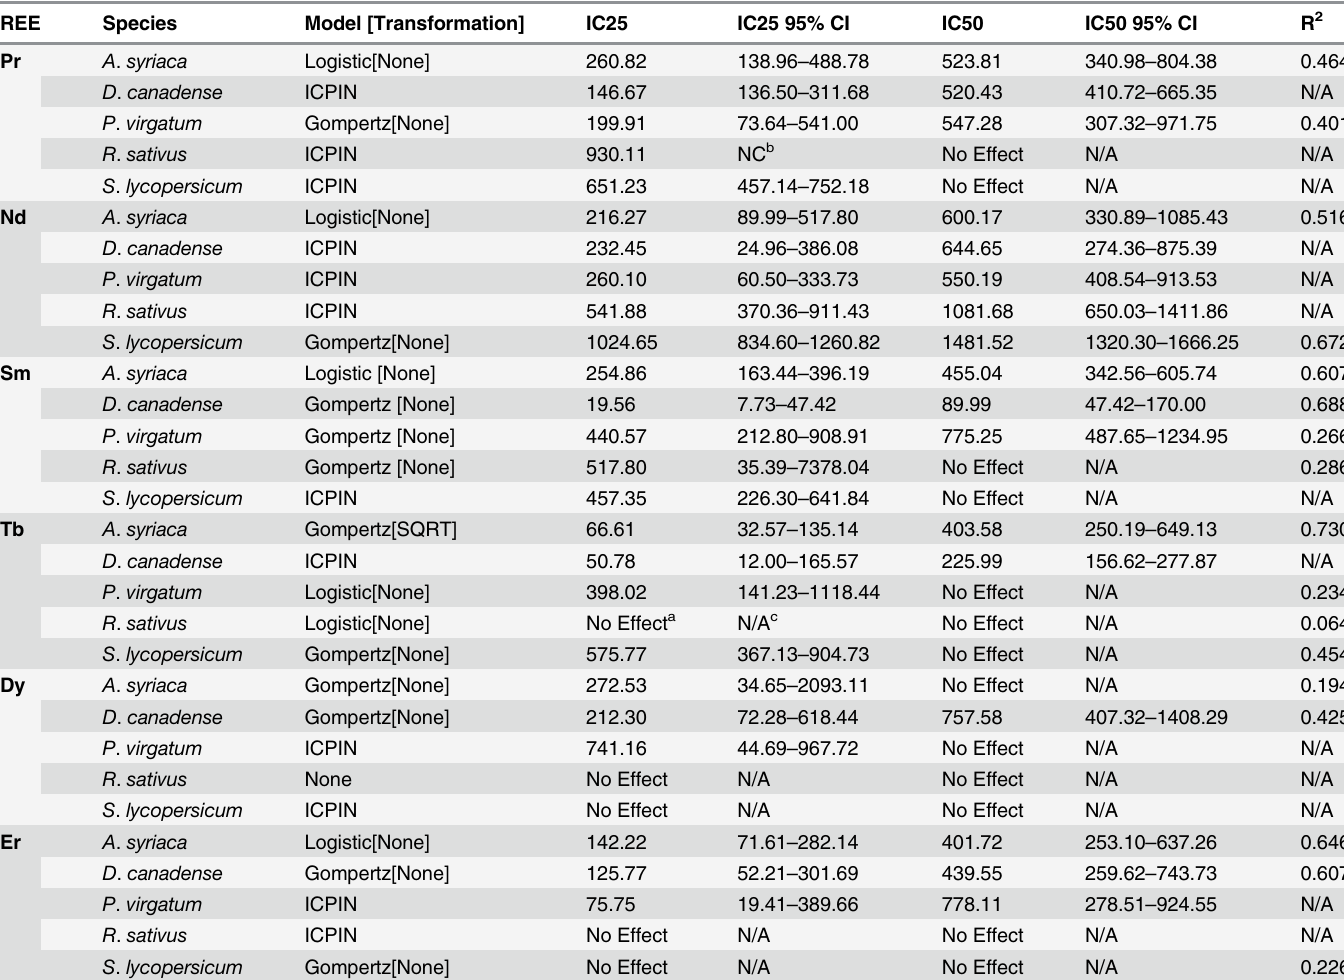
Table 5. Summary of inhibition concentration (IC) values, calculated as the dosage (mg REE/kg dry soil) resulting in either a 25% (IC25) or 50% (IC50) decrease in the dry biomass of exposed plants as compared to the controls, for all plant species grown in rare earth element (REE) contami- nated